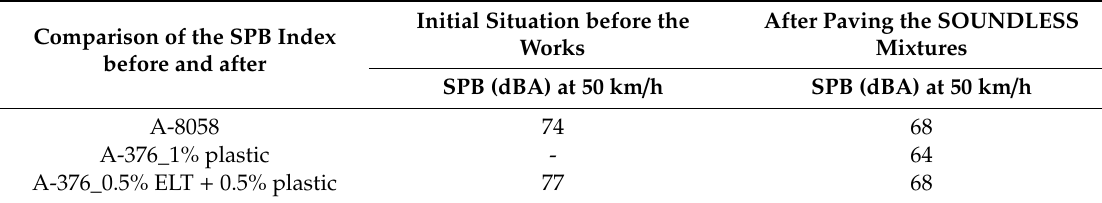
Table 4. SPB values before and after paving the mixtures.